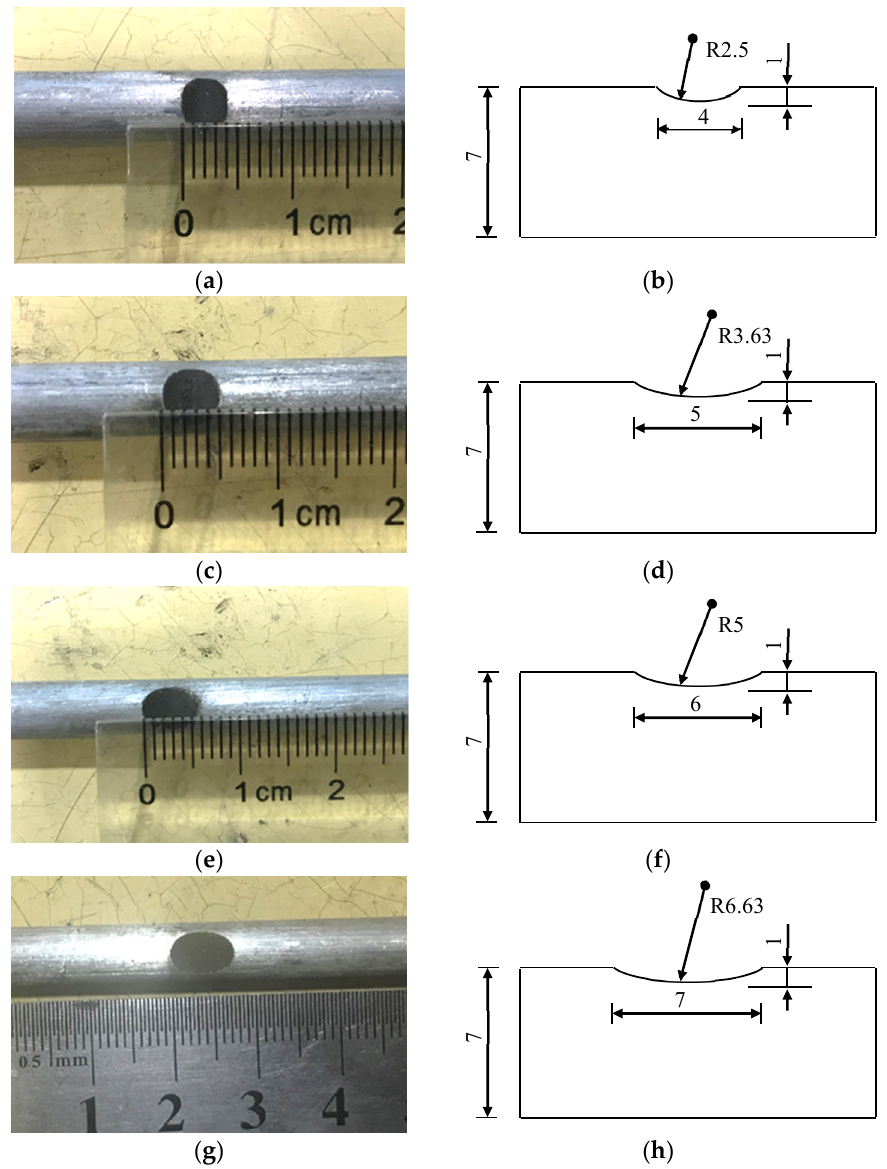
Figure 20. Wire specimens with semi-ellipsoidal notches of different widths. ( a ) No. L-1 steel wire specimen; ( b ) dimension of No. L-1 steel wire; ( c ) No. L-2 steel wire specimen; ( d ) dimension of No. L-2 steel wire; ( e ) No. L-3 steel wire specimen; ( f ) dimension of No. L-3 steel wire; ( g ) No. L-4 steel wire specimen; and ( h ) dimension of No. L-4 steel wire.